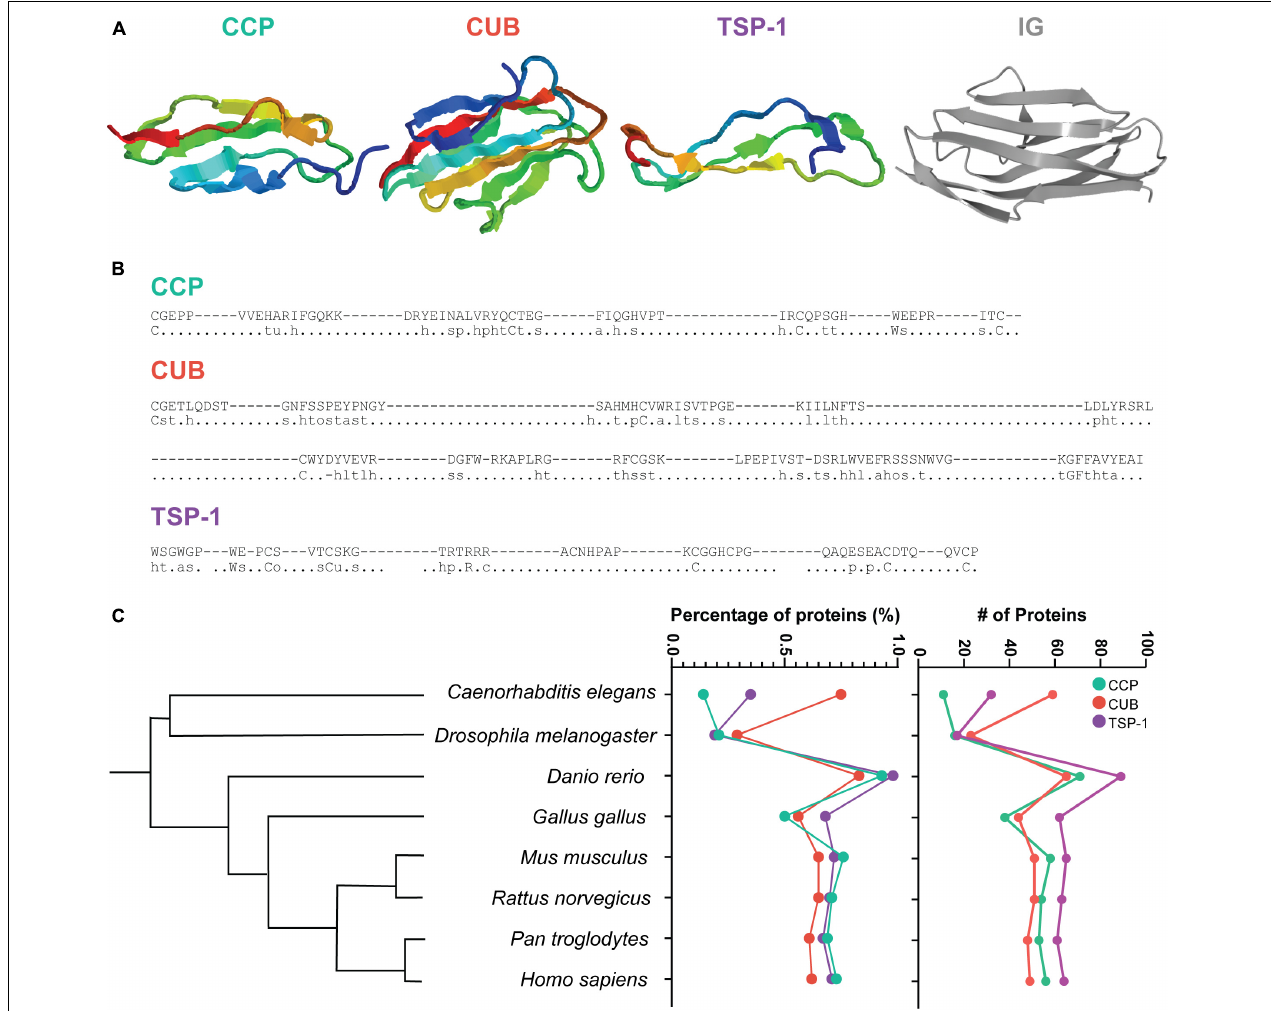
FIGURE 1 | CCP, CUB, and TSP-1 domains. (A) Three-dimensional structure of a CCP domain (from rat GABA B Receptor 1a (Blein et al., 2004), PBD id:1srz), a CUB domain (from human tumor necrosis factor-inducible gene 6 protein (Briggs et al., 2015), PDB id: 2wno), a TSP-1 domain (from rat F-spondin (Pääkkönen et al., 2006), PDB id: 1szl) and a IG domain (from mouse NCAM (Jensen et al., 1999), PDB id: 3ncm). Adapted from ebi.ac.uk/pdbsum (B) For each domain, an example is given (top sequence: β -2-glycoprotein 1 from Bos Taurus (PGCA_BOVIN/1-5) for the CCP domain; bone morphogenetic protein 1 from Homo sapiens (BMP1_HUMAN/1-1) for the CUB domain and Properdin from Homo sapiens (PROP_HUMAN/2-0) for the TSP-1 domain), as well as the consensus terms (80%, bottom sequence). Adapted from smart.embl.de. (C) Number and percentage of proteins containing CCP, CUB, or TSP-1 domains (green, red and purple, respectively, right) for different species ordered via a phylogenetic tree (left). Data from SMART genomic mode domain evolution (smart.embl.de) and the interactive Tree of Life